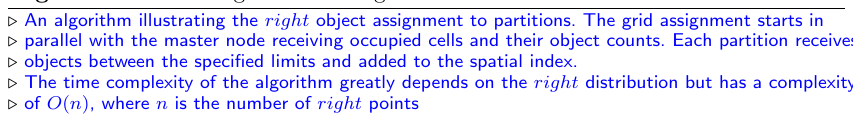
Algorithms Algorithm 1 Building and Indexing the Partitioner